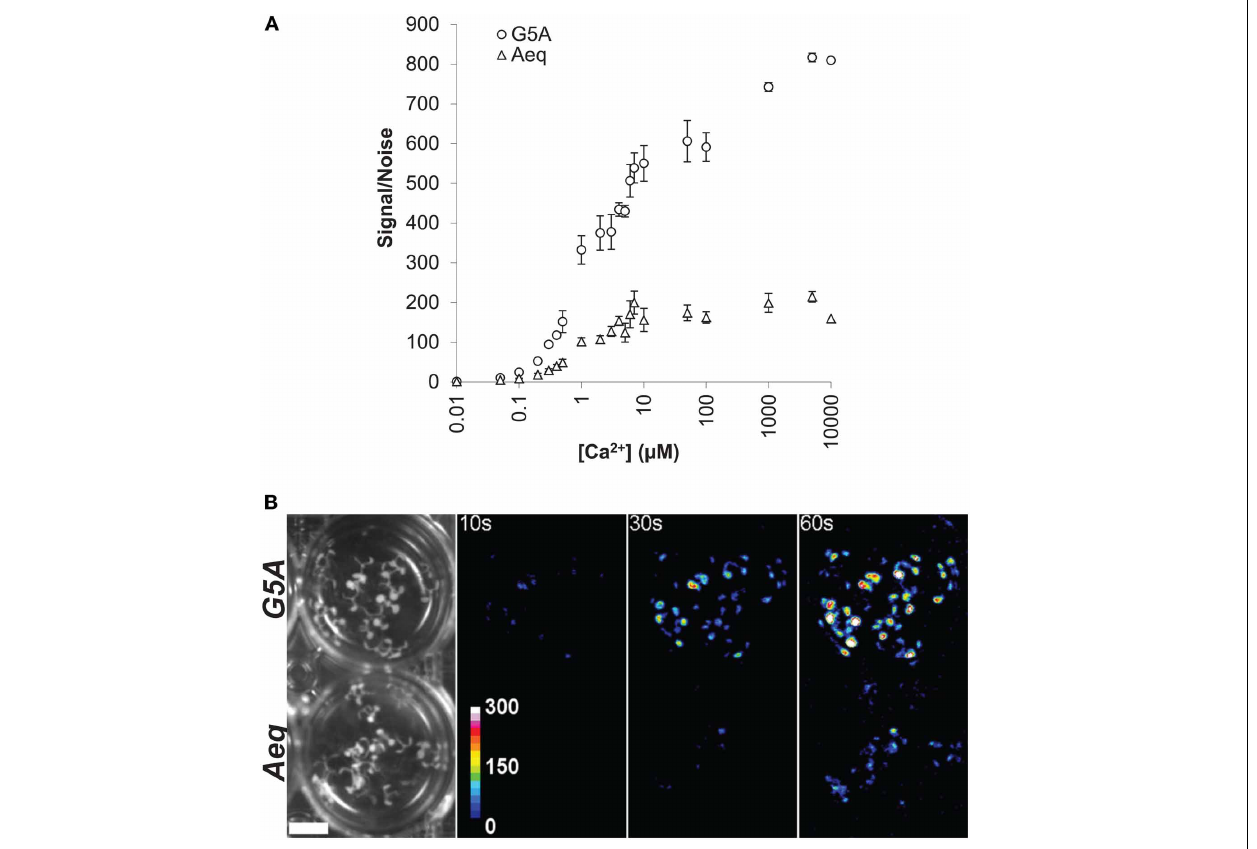
Ca 2 + signals emitted from 7 day-old G5A (top) and Aeq (bottom) plants over different exposition time lapses (10, 30, and 60s). Left panel shows bright field view (scale bar = 1cm) of the imaged plants. The other panels display cumulative Ca 2 + responses in false colors (color scale in the 10 s-labeled